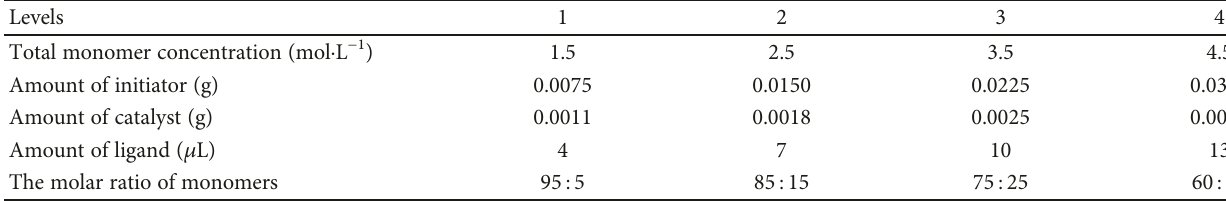
Table 1: Factors of the orthogonal experiments (L5 4